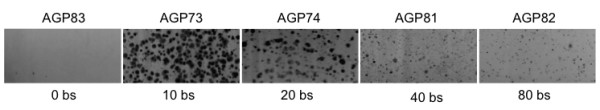
Plasmids with an FR containing more than 20 EBNA1 binding sites form minute colonies under selection. The indicated plasmids were transfected into 293/EBNA1 cells, which were subjected to puromycin selection for 18 days in colony formation assays as described in the Materials and Methods section. Representative images of methylene blue stained colonies are shown. The identity of the transfected plasmid is indicated above each image, and the number of EBNA1 binding sites present in the FR of each plasmid is indicated below each image. As a negative control, an assay was also performed with AGP83, a DS-only plasmid that replicates transiently, but is not partitioned, and forms colonies with very low efficiency. The colonies formed from cells transfected with AGP81 and AGP82 did not increase in size even after several weeks of growth in selective media. The number of colonies formed in such assays that were 2 mm in size and larger is indicated in Table 1.